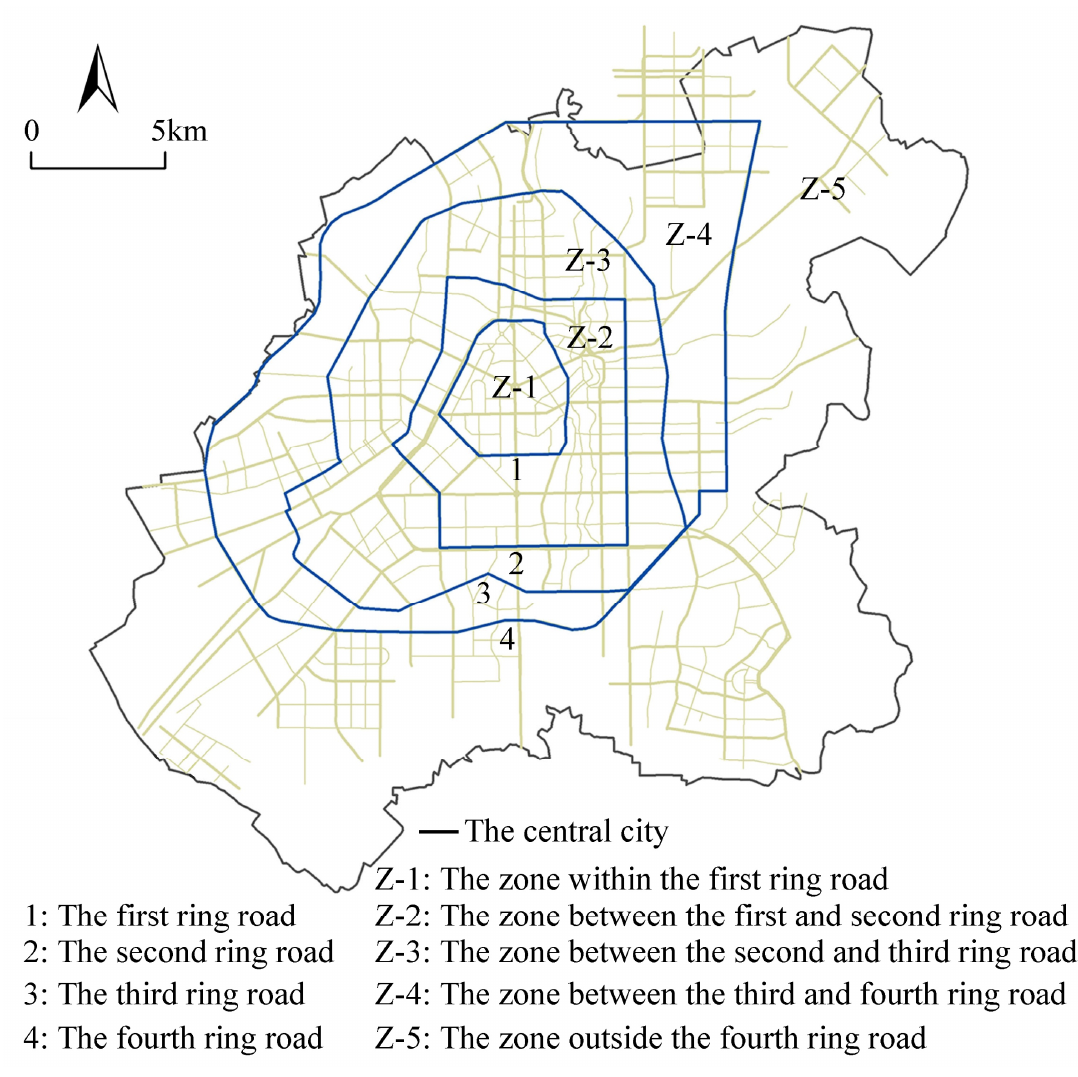
Figure 2. Concentric circle division of the central city.